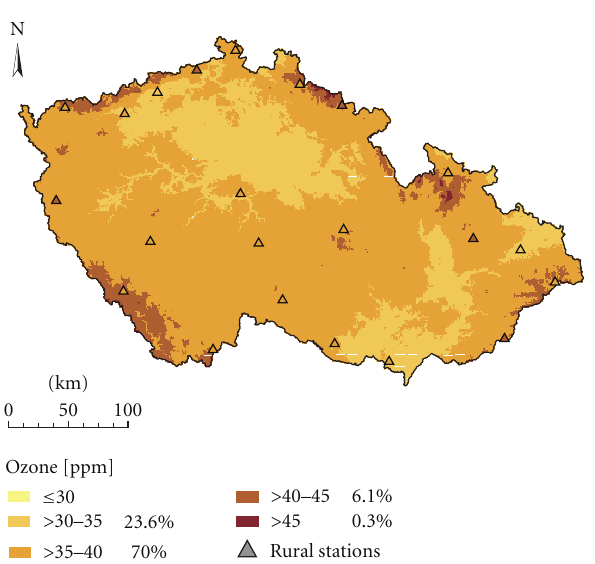
Figure 2: Spatial interpolation of mean O 3 concentrations in the 2008 vegetation season (ppb), interpolation technique LR + res OK, grid resolution 1 × 1km.